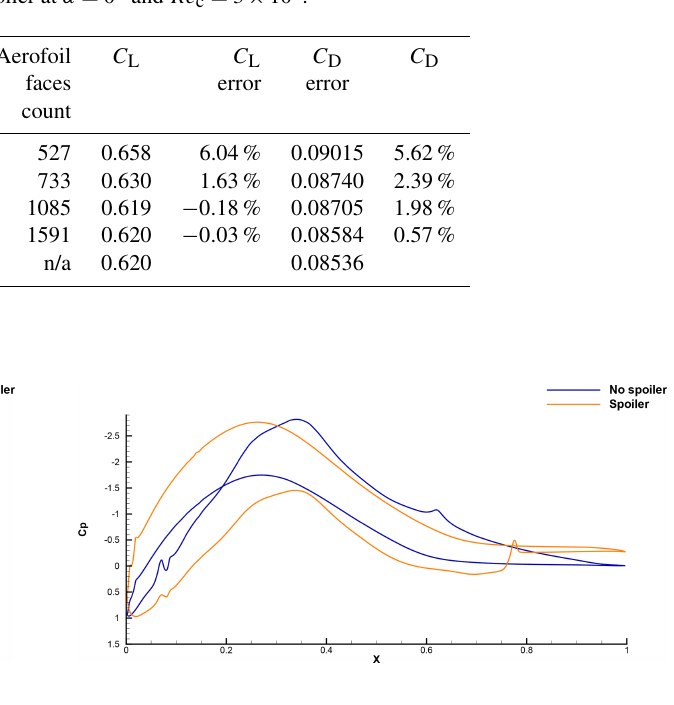
Figure 6. Average wall pressure coefficient plot for α = 6 ◦ and Re c = 3 × 10 6